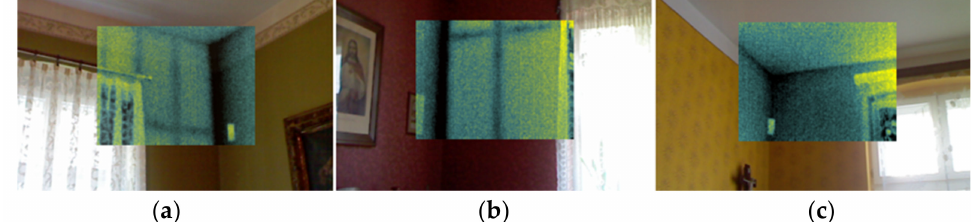
Figure 8. Diagram of the temperature distribution at the junction of the external walls of the building (Figure 5a), with the front wall insulated from the inside and the gable wall from the outside: ( a ) view of the wall, ( b ) thermal bridge system in the place of the grate and in the corner, ( c ) temperature diagram covering the corner— ∆ T = 3.4 ◦